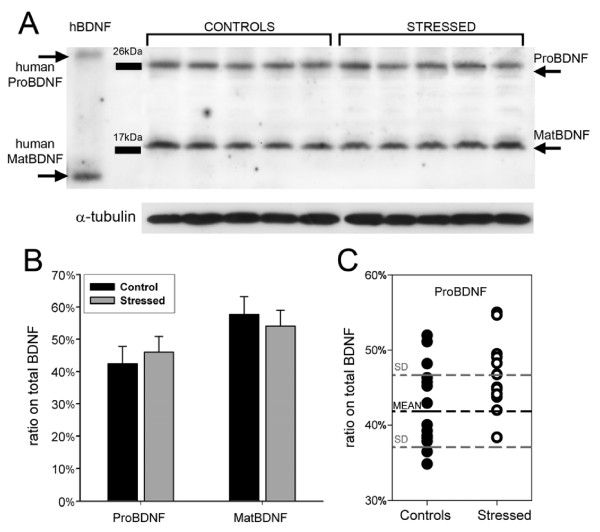
Stress does not alter the ratio of pro/matBDNF in the seabass liver. A) A representative Western blot of proBDNF and matBDNF expression in the seabass liver. Alpha-tubulin (MW 55 KDa) is used for normalization. Human recombinant proBDNF and matBDNF shows reactivity of the anti-BDNF antibody. The bands corresponding to the seabass proBDNF and matBDNF are indicated on the right side. B) Mean percentage of proBDNF vs. total BDNF (totalBDNF = proBDNF+matBDNF) of 10 control and 10 stressed animals. Error bars represent SE. No significant difference between control and stressed animals was found. C) Scatter-plot showing the large overlap of the percentage of proBDNF on total BDNF in individual animals from the control and the stressed populations. The F values, obtained by One way Anova analysis, for proBDNF and mature BDNF were 4.154 and 0.055, respectively.